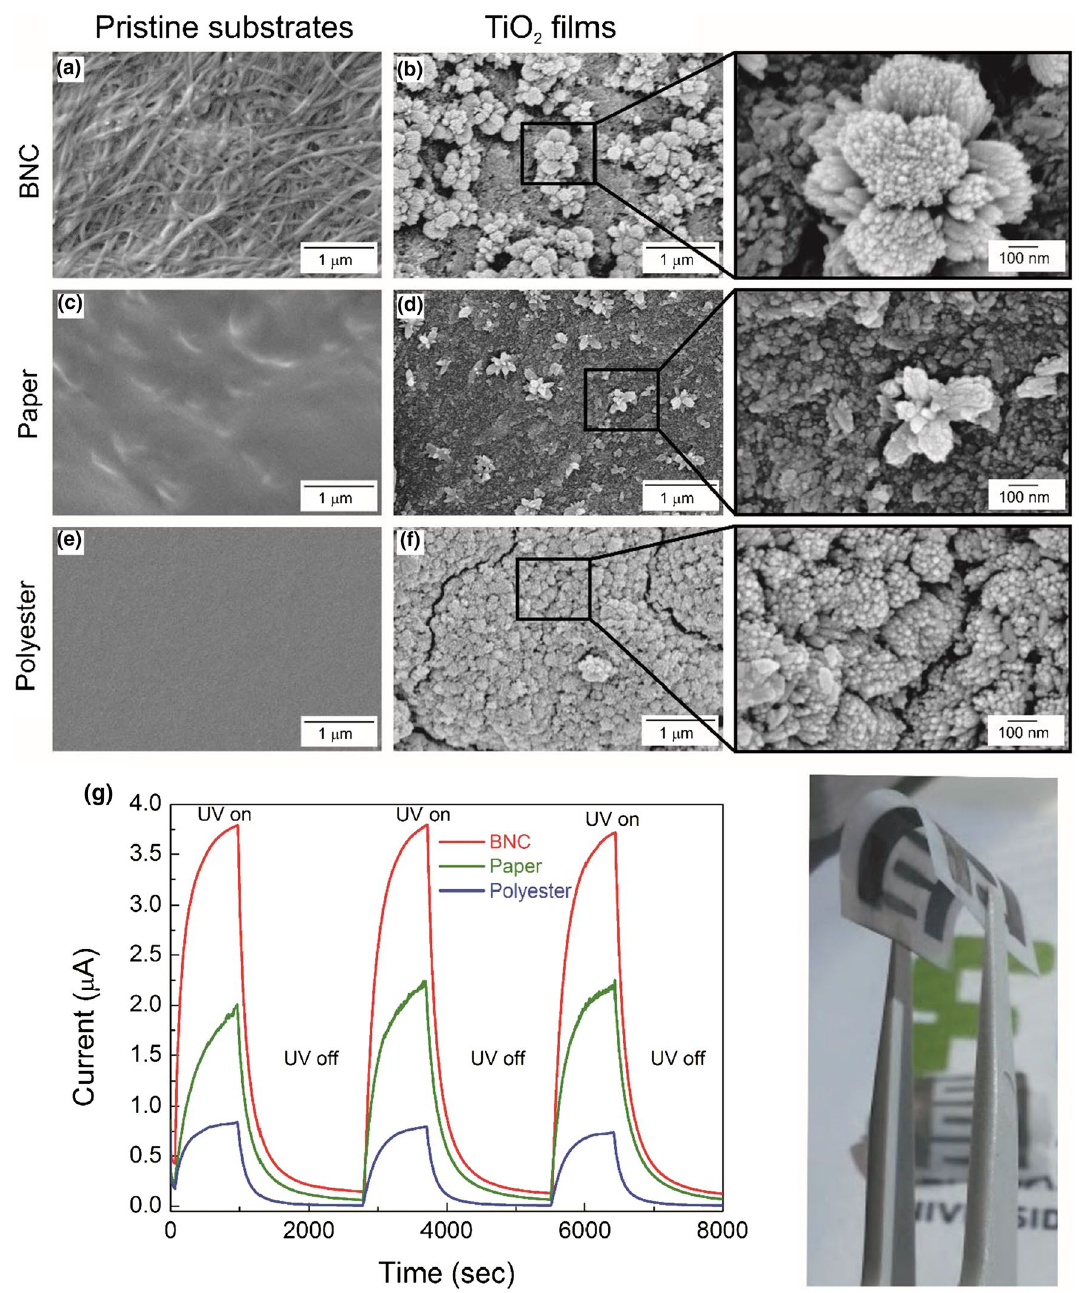
g Cycling behaviour of TiO film photodetectors at 10 V and under a 360 nm UV source, together with the real image of a sensor. Repro- 2 duced from [14] with permission of Springer